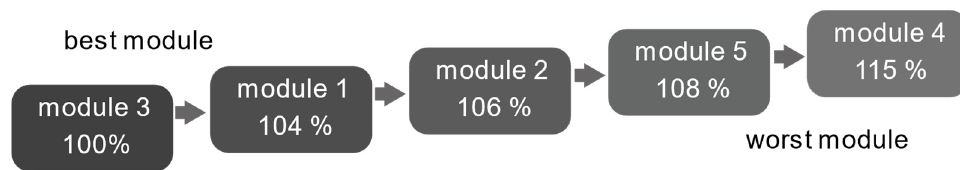
Figure 10. Quantitative evaluation of module aging by the CI method at 30% SOC.